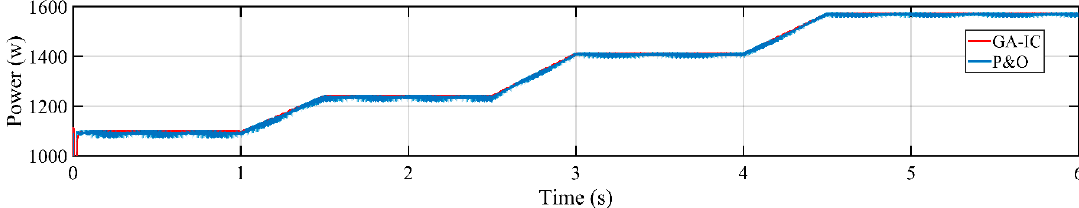
Figure 23. Case 2 duty cycle, zoomed in comparison of modified GA-IC vs. P&O. Energies 2020 , 13 , x FOR PEER REVIEW